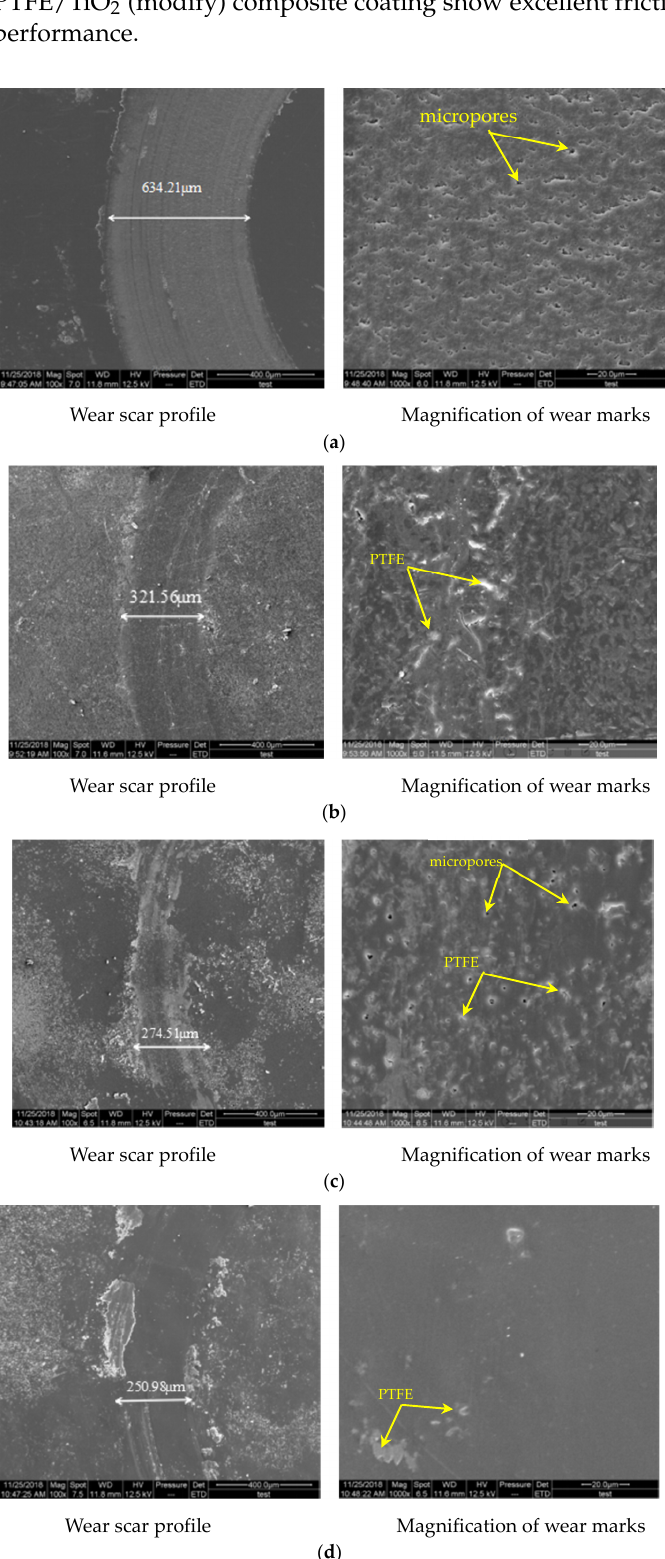
Figure 7. Wear scar morphology of different coatings. ( a ) unmixed epoxy, ( b ) epoxy–PTFE, ( c ) epoxy–PTFE/TiO 2 (unmodify), ( d ) epoxy–PTFE/TiO 2